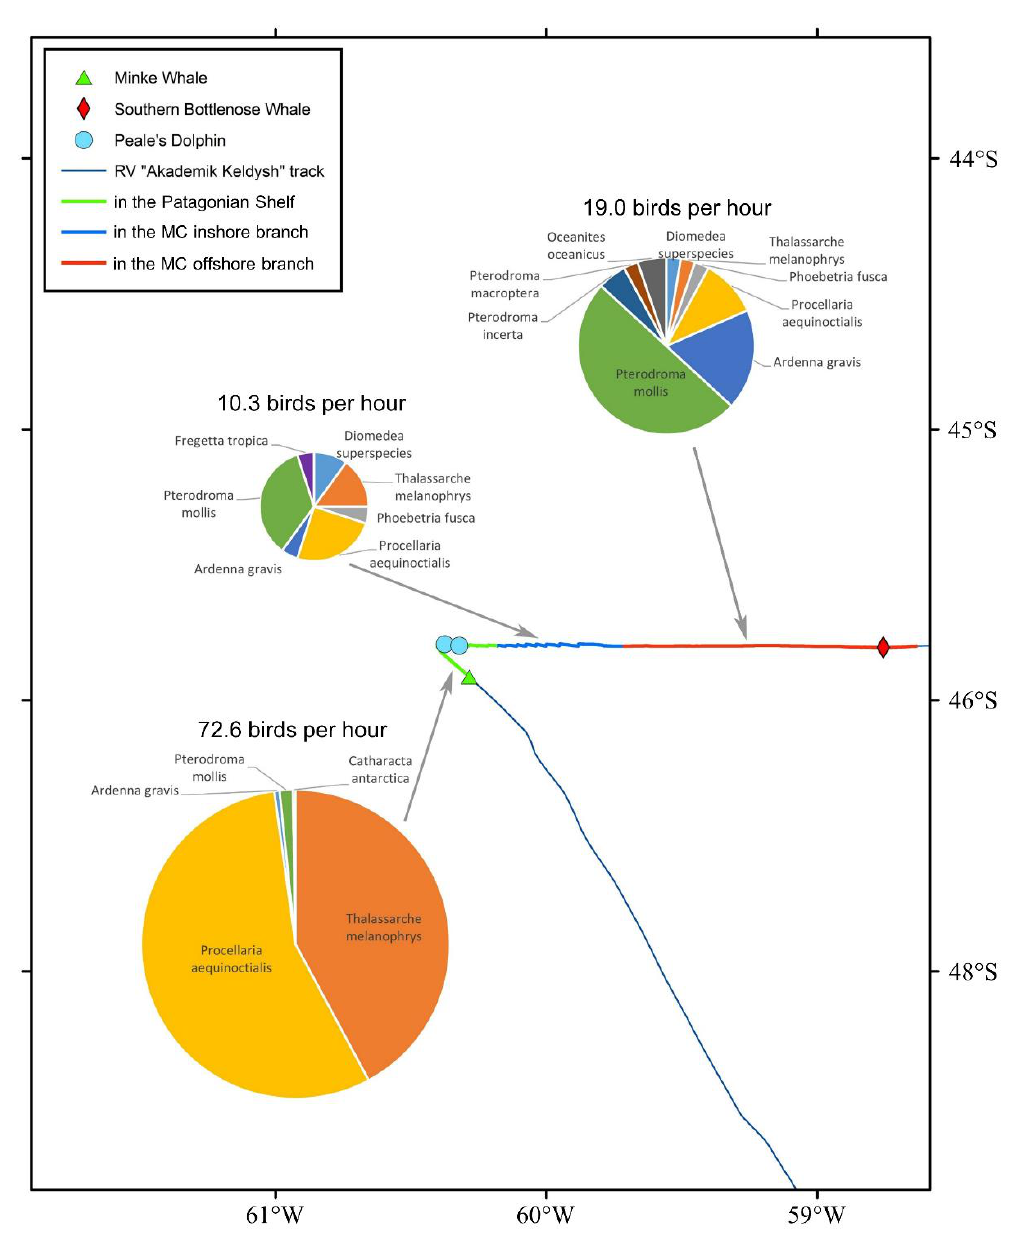
Figure 12. The ratio of the bird species at each site and sightings of marine